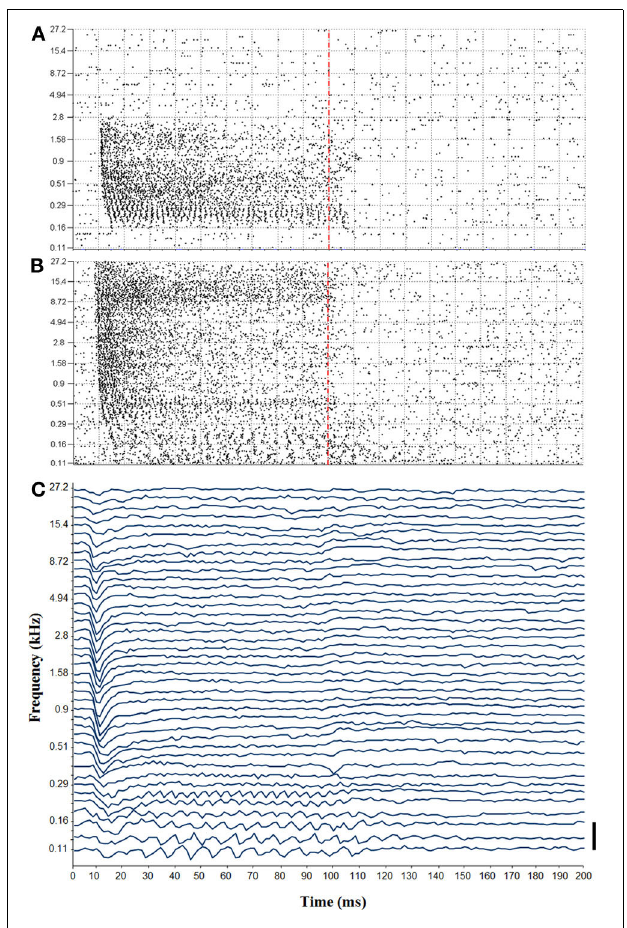
FIGURE 3 | (A) Tuning curve recorded from the left red nucleus. Vertical dashed line indicates the end of the tone bursts. (B) Tuning curve from the right red nucleus. Note the temporal coding showing phase locking to low frequency tones. (C) Auditory-evoked potential recorded in responses to tone bursts from the right red nucleus (bar = 100 µ